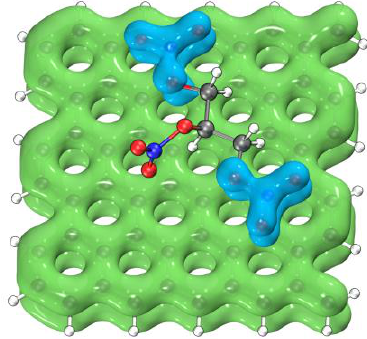
Figure 11. The maps of the isosurface of LOL of some π -LMOs with an isovalue of 0.2. The lime isosurface is the area which belongs to the graphene. The cyan isosurface is the area which belongs to the NG.